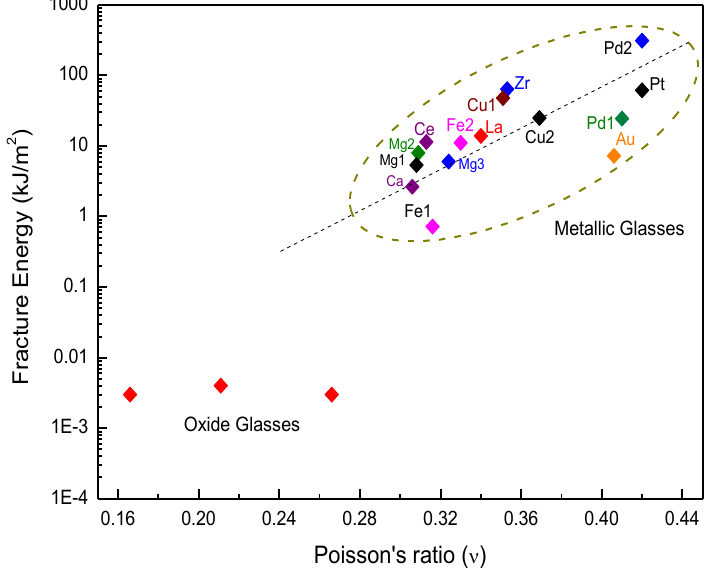
Figure 6. The correlation between mode II fracture energy (based on shear band vein patterns) and Poisson’s ratio. The BMGs represented are, Fe1 : Fe Fe2 : Fe Mg3 : Mg Cu2 : Cu Au : Au tougher than oxide glasses and their toughness gradually increases with Poisson’s